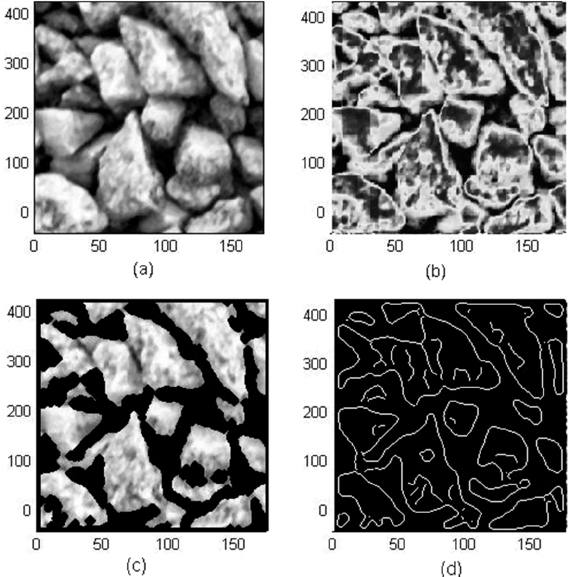
Figure 4. ( a ) Original image; ( b ) discretized image; ( c ) cropped image; ( d ) Canny